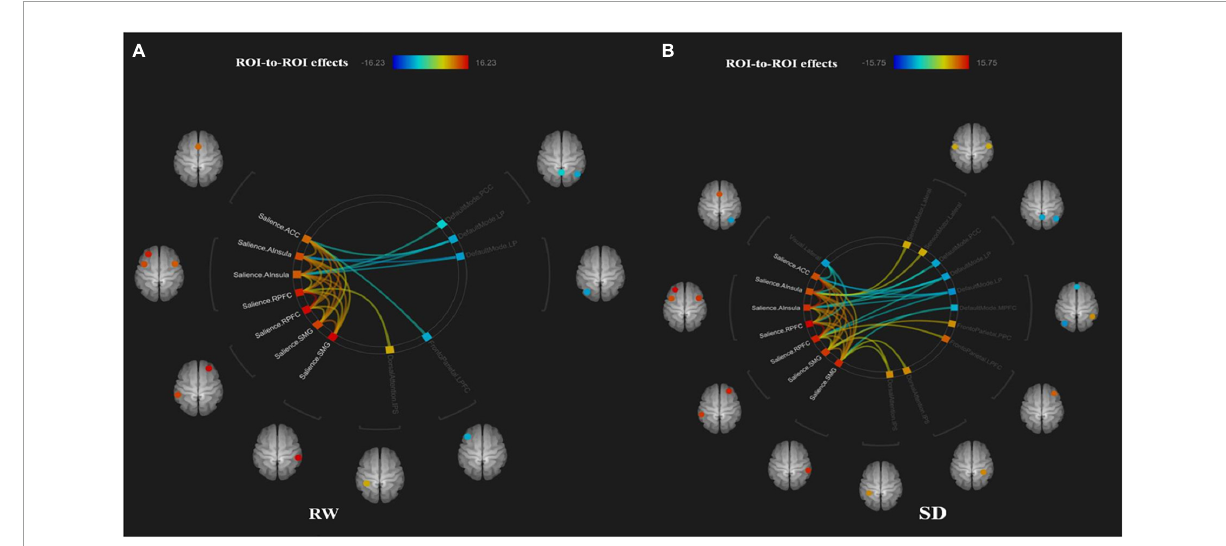
FIGURE5 ROI-to-ROI connectivity of six networks in panels (A) rested wakefulness (RW) and (B) total sleep deprivation (TSD) scans [ p < 0.001 FDR set wise corrected for all comparisons across the entire network]. ROI, region of interest; SD, sleep deprivation; DMN, default mode network; SMN, sensorimotor network; VN, visual network; SN, salience network; DAN, dorsal attention network; ventral attention and frontal-parietal control network (FPN).